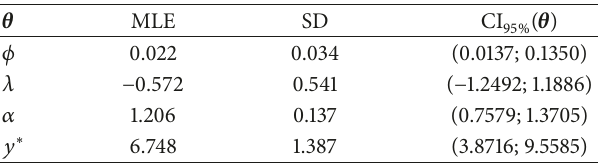
Table 13: MLEs, standard deviations, and 95 % confidence intervals for 𝛼 , 𝜃 , 𝜎 , and 𝑦 ∗ related to the EPW